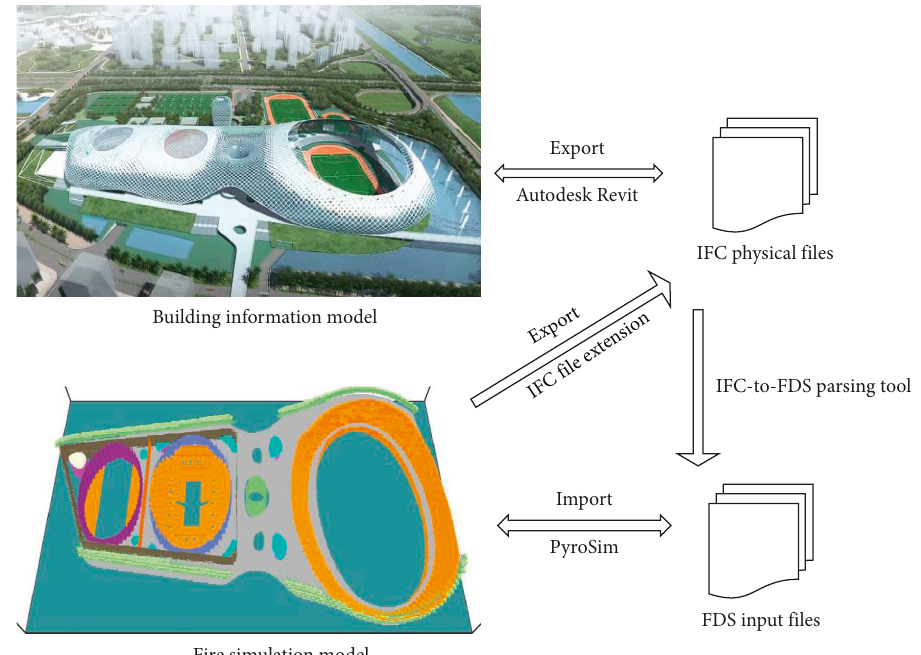
Figure 19: IFC- and FDS-based information sharing.